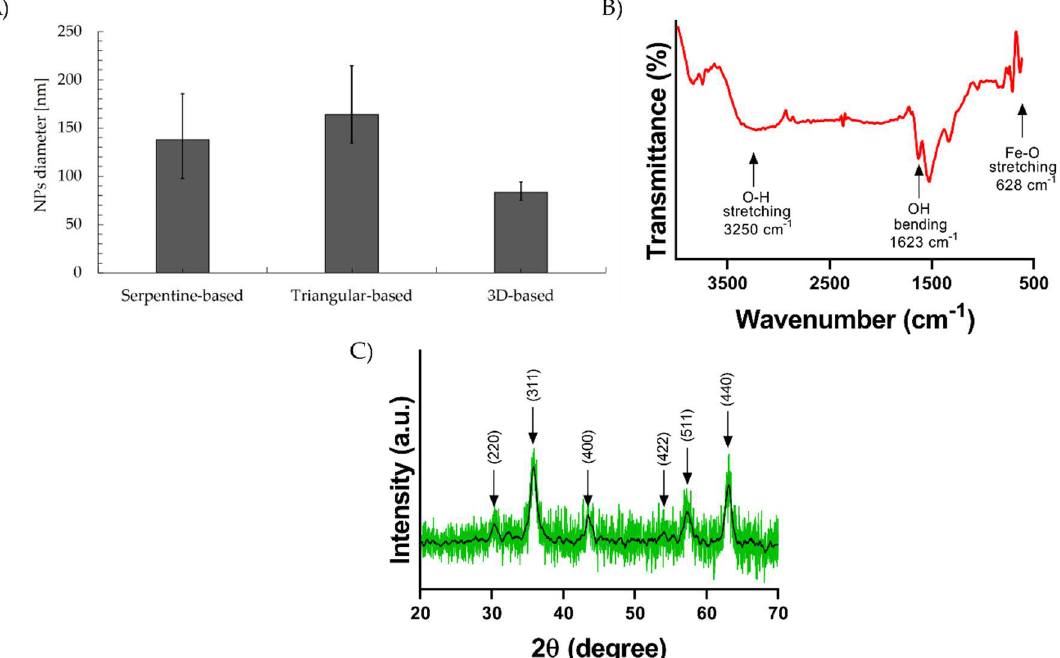
Figure 8. Magnetic nanoparticle characterizations. ( A ) Average diameter of the magnetite nanopar- ticles produced by each micromixer. For the serpentine−based (SB) micromixer, it approached 138.00 ± 44.00 nm, for the triangular−based (TB) micromixer, it was 163.57 ± 40.15 nm, and finally, for the 3D−based (3DB) micromixer, it was 83.03 ± 9.52 nm. ( B ) FTIR of representative spectra of NPs. ( C ) XRD representative diffractogram of the NPs.